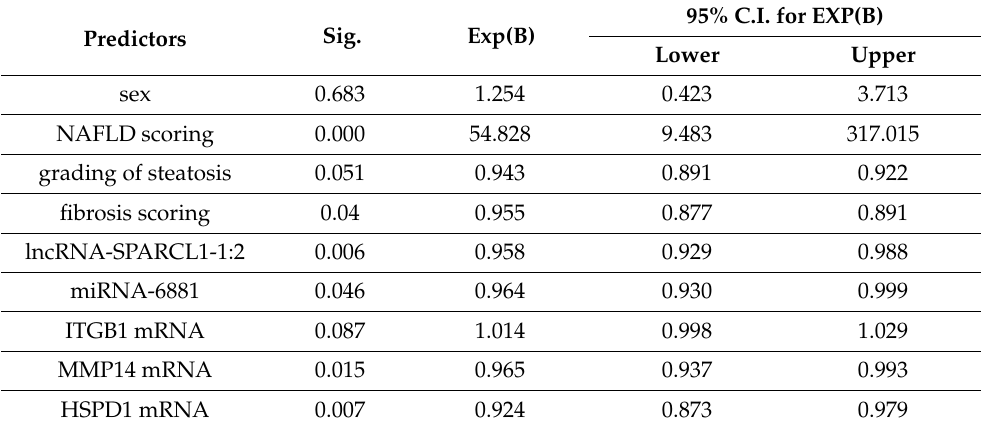
Table 3. Showing multivariate regression analysis.